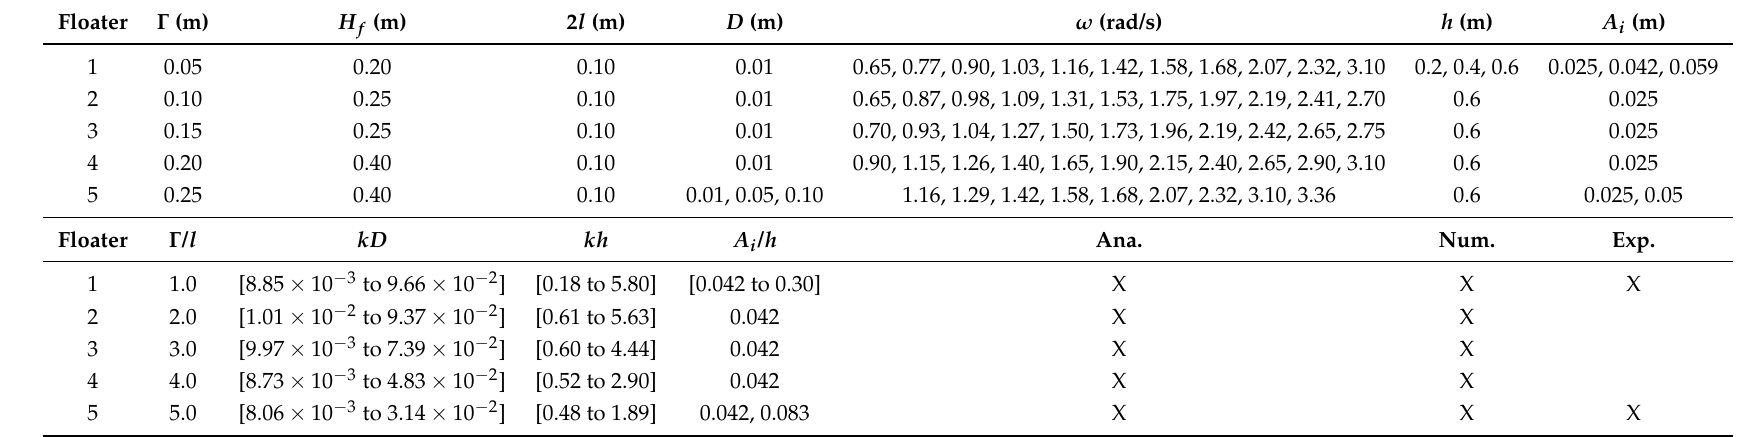
Figure 4. Picture and scheme of the experimental set-up. Table 2. Various floater dimensions, tested conditions and dimensionless